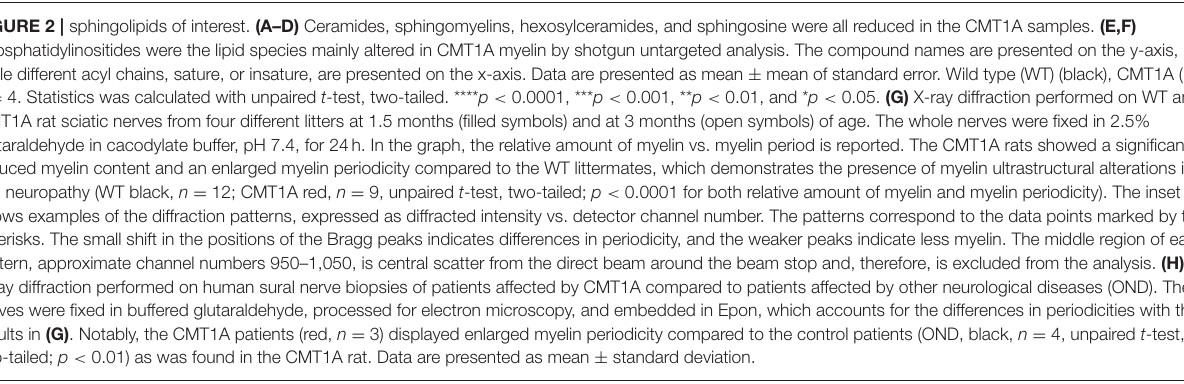
FIGURE 2 | sphingolipids of interest. (A–D) Ceramides, sphingomyelins, hexosylceramides, and sphingosine were all reduced in the CMT1A samples. (E,F) Phosphatidylinositides were the lipid species mainly altered in CMT1A myelin by shotgun untargeted analysis. The compound names are presented on the y-axis, while different acyl chains, sature, or insature, are presented on the x-axis. Data are presented as mean ± mean of standard error. Wild type (WT) (black), CMT1A (red) n = 4. Statistics was calculated with unpaired t -test, two-tailed. **** p < 0.0001, *** p < 0.001, ** p < 0.01, and * p < 0.05. (G) X-ray diffraction performed on WT and CMT1A rat sciatic nerves from four different litters at 1.5 months (filled symbols) and at 3 months (open symbols) of age. The whole nerves were fixed in 2.5% glutaraldehyde in cacodylate buffer, pH 7.4, for 24h. In the graph, the relative amount of myelin vs. myelin period is reported. The CMT1A rats showed a significantly reduced myelin content and an enlarged myelin periodicity compared to the WT littermates, which demonstrates the presence of myelin ultrastructural alterations in this neuropathy (WT black, n = 12; CMT1A red, n = 9, unpaired t -test, two-tailed; p < 0.0001 for both relative amount of myelin and myelin periodicity). The inset shows examples of the diffraction patterns, expressed as diffracted intensity vs. detector channel number. The patterns correspond to the data points marked by the asterisks. The small shift in the positions of the Bragg peaks indicates differences in periodicity, and the weaker peaks indicate less myelin. The middle region of each pattern, approximate channel numbers 950–1,050, is central scatter from the direct beam around the beam stop and, therefore, is excluded from the analysis. (H) X-ray diffraction performed on human sural nerve biopsies of patients affected by CMT1A compared to patients affected by other neurological diseases (OND). The nerves were fixed in buffered glutaraldehyde, processed for electron microscopy, and embedded in Epon, which accounts for the differences in periodicities with the results in (G) . Notably, the CMT1A patients (red, n = 3) displayed enlarged myelin periodicity compared to the control patients (OND, black, n = 4, unpaired t -test, two-tailed; p < 0.01) as was found in the CMT1A rat. Data are presented as mean ± standard